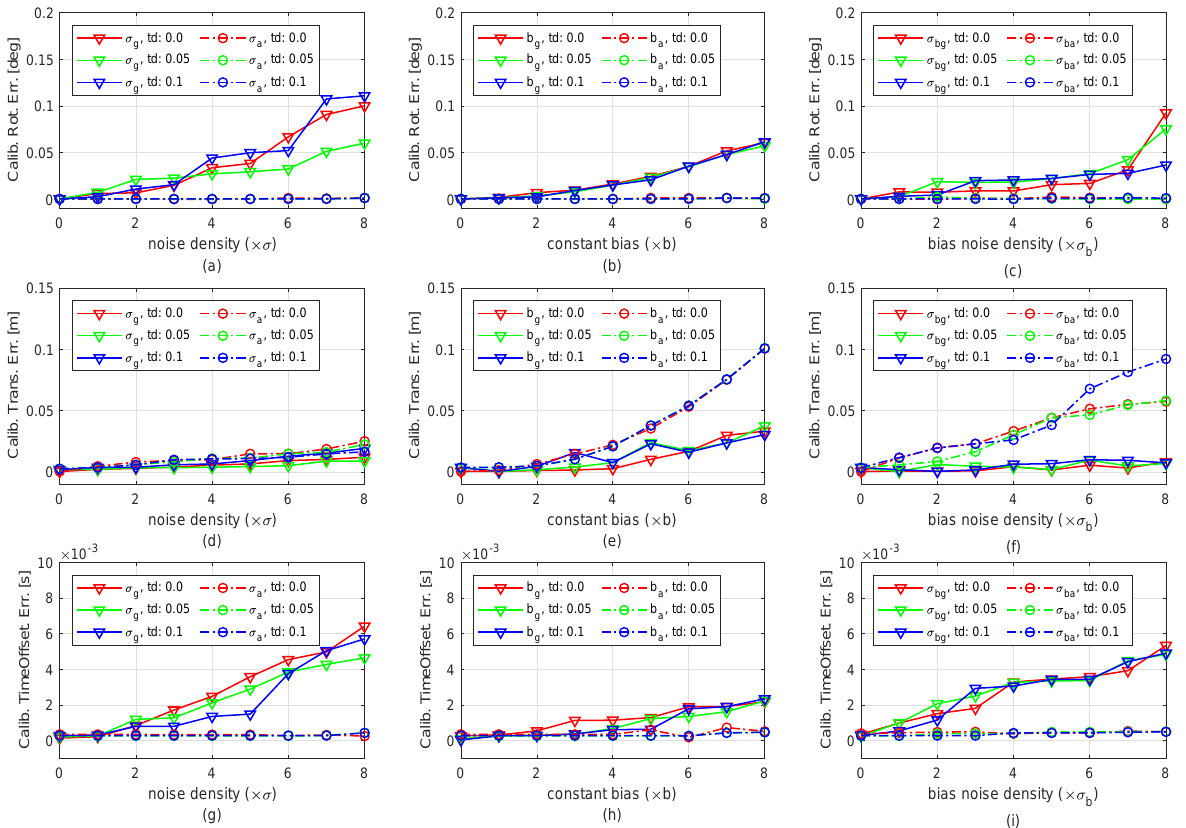
Figure 6. Spatial-temporal calibration errors in the presence of various gyroscope and accelerometer noises. The vertical axes of ( a – c ), ( d – f ), and ( g – i ) subplots are, respectively, the calibration error of extrinsic camera-IMU rotation, translation, and time offset. The horizontal axes of the subplots in the first column, the second column, and the third column are, respectively, the intensities of measurement noise density, constant bias, and bias “diffusion” random walk noise density. For instance, the labels “0” in all the horizontal axes represent the ideal noise-free measurements. The label “4” in the horizontal axis of ( a ) means the measurement noise density is customized to 4 σ g (for evaluating the robustness on gyroscope measurement noise, of which results are shown in solid curves) or 4 σ a (for evaluating the robustness on accelerometer measurement noise, of which results are shown in dash-dot curves), while the other noises are customized to zeros. Best viewed in color. Figure 6d–f compare the translation errors of calibration under different